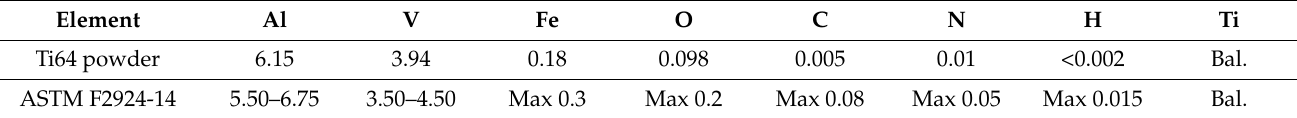
Table 1. Chemical composition of Ti64 powder (wt.%).